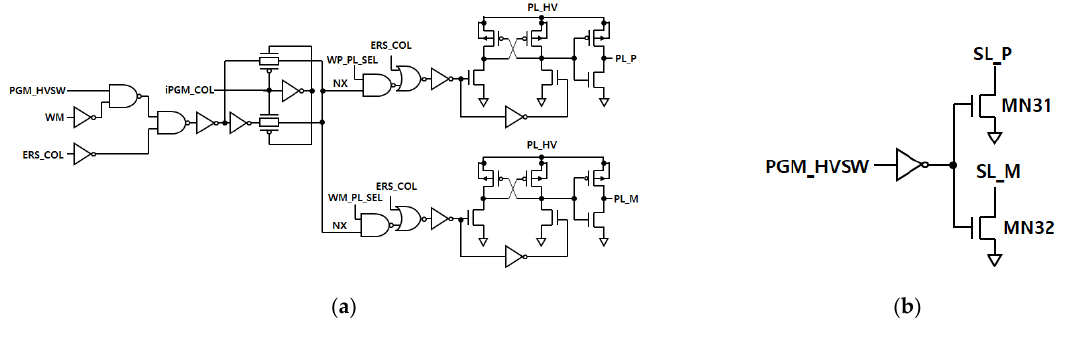
Table 5. Cell bias conditions for ‘TEST read’ and ‘read’ mode in the proposed synaptic cell.